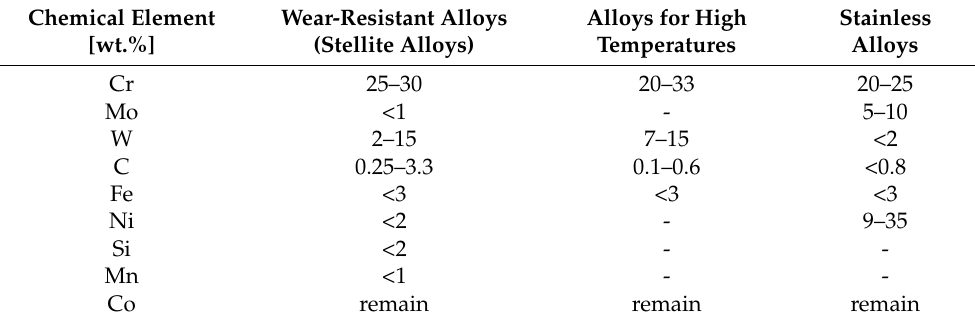
Table 6. Chemical composition of special cobalt alloys.